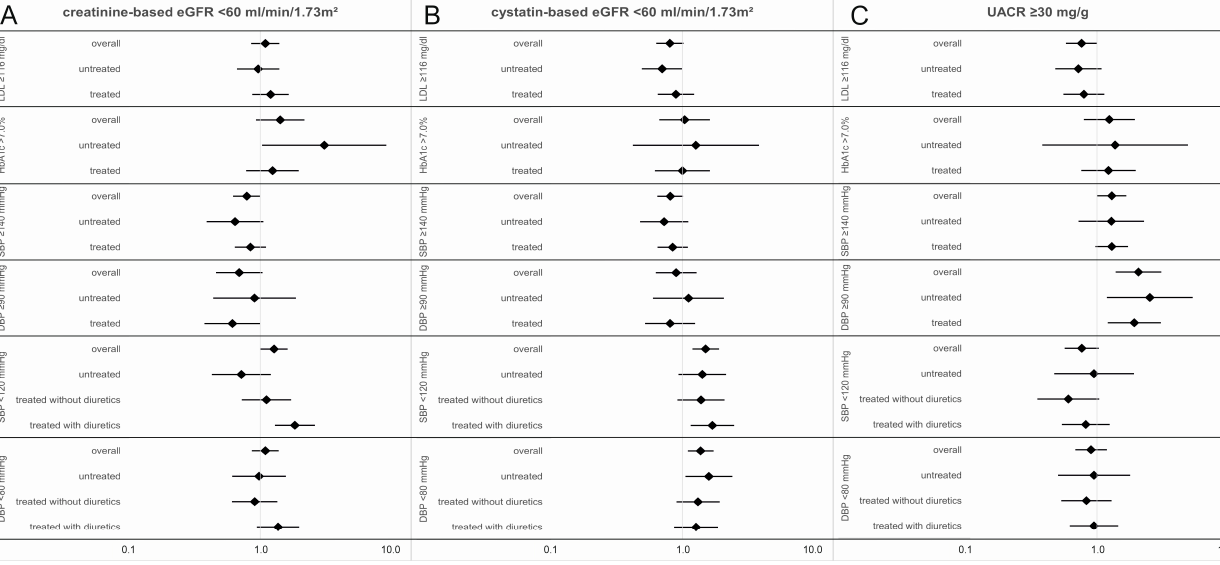
Figure 2. Association of unachieved cardiovascular risk factor control with impaired kidney function. Shown are odds ratios and 95% confidence intervals for the association of unachieved risk factor control with creatinine- or cystatin-based eGFR < 60 mL/min/1.73 m² ( A , B ) and with UACR ≥ 30 mg/g ( C ). We applied logistic regression adjusted for age, sex, CAD/stroke, diabetes (if applicable), obesity (BMI ≥ 30 vs. <30 kg/m²), smoking (ever vs. never), and respective medication intake without interaction (overall model). We also applied a model adding an interaction between treatment and risk factor control, ~b0 + b1age + b2sex + b3CAD/stroke + b4diabetes + b5obesity + b6smoking + b7treatment + b8control + b9treatment * control; we derived the ORs for treated individuals by exp(b8 + b9) with corresponding 95% CIs (details in Supplementary Table S3). For low SBP/DBP, we used two variables for “treatment” (“treated without diuretics”: 1 = antihypertensives without diuretics, 0 = otherwise; “treated with diuretics”: 1 = diuretics, 0 = otherwise) and respective interaction parameters.